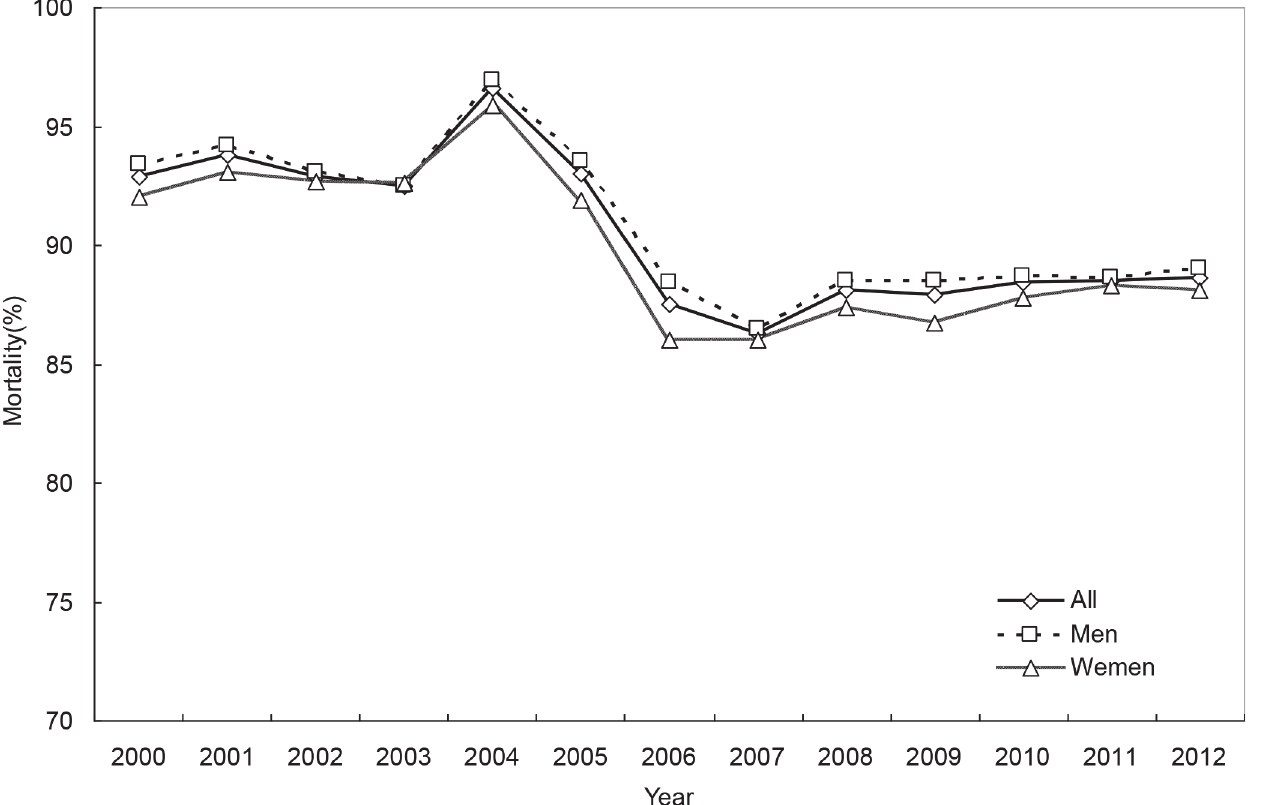
Fig 8. 180-day mortality rates of out-of-hospital cardiac arrest, for both genders combined and by